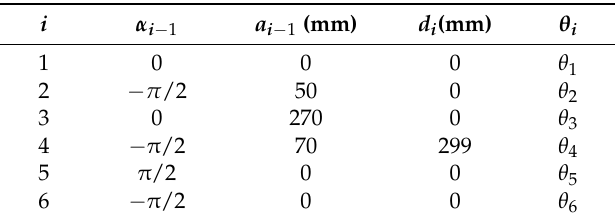
Table 1. Link parameters of the Efort robot.